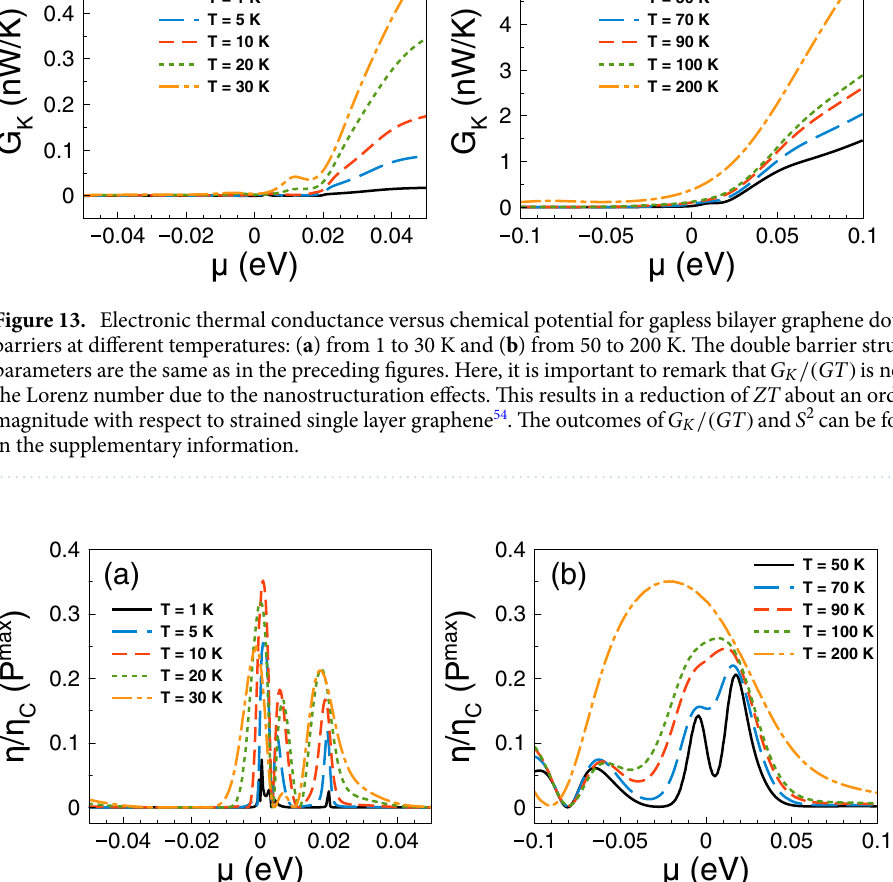
Figure 14. Efficiency at maximum power versus chemical potential for gapless bilayer graphene single barriers at different temperatures: ( a ) from 1 to 30 K and ( b ) from 50 to 200 K. The double barrier structural parameters are the same as in the preceding figures. The maximum efficiency is reached at the temperatures at which ZT is maximum as